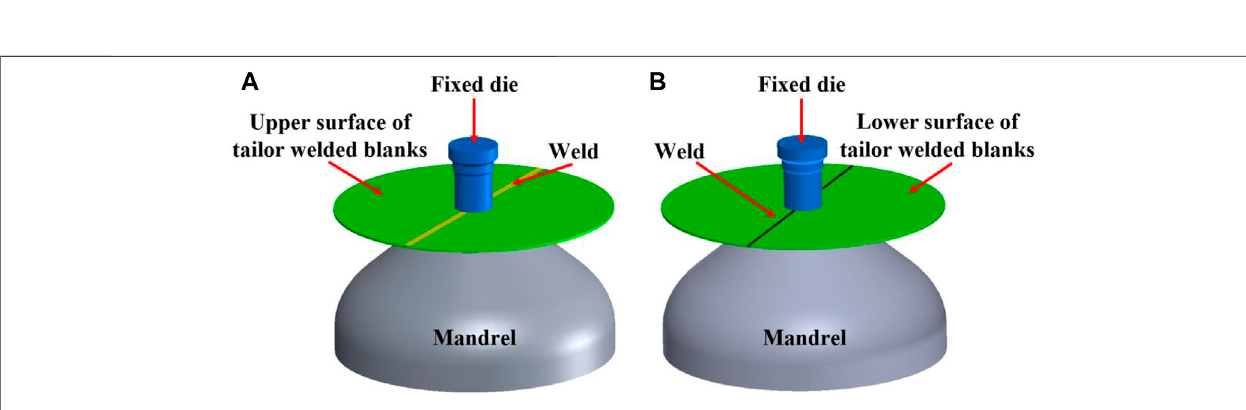
Frontiers in Materials |